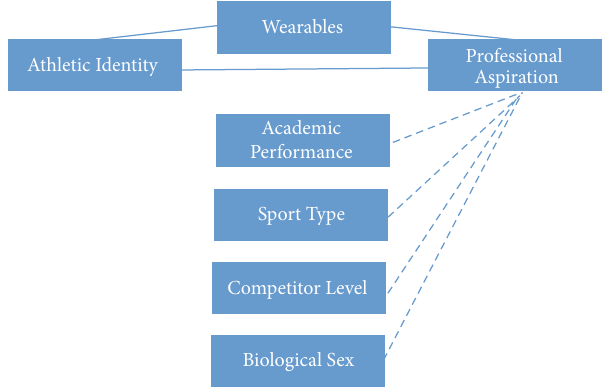
Figure 1: Mediation model of wearables in the relationship between athletic identity and professional aspiration, with athletic perfor- mance, sport type, and competitor level as